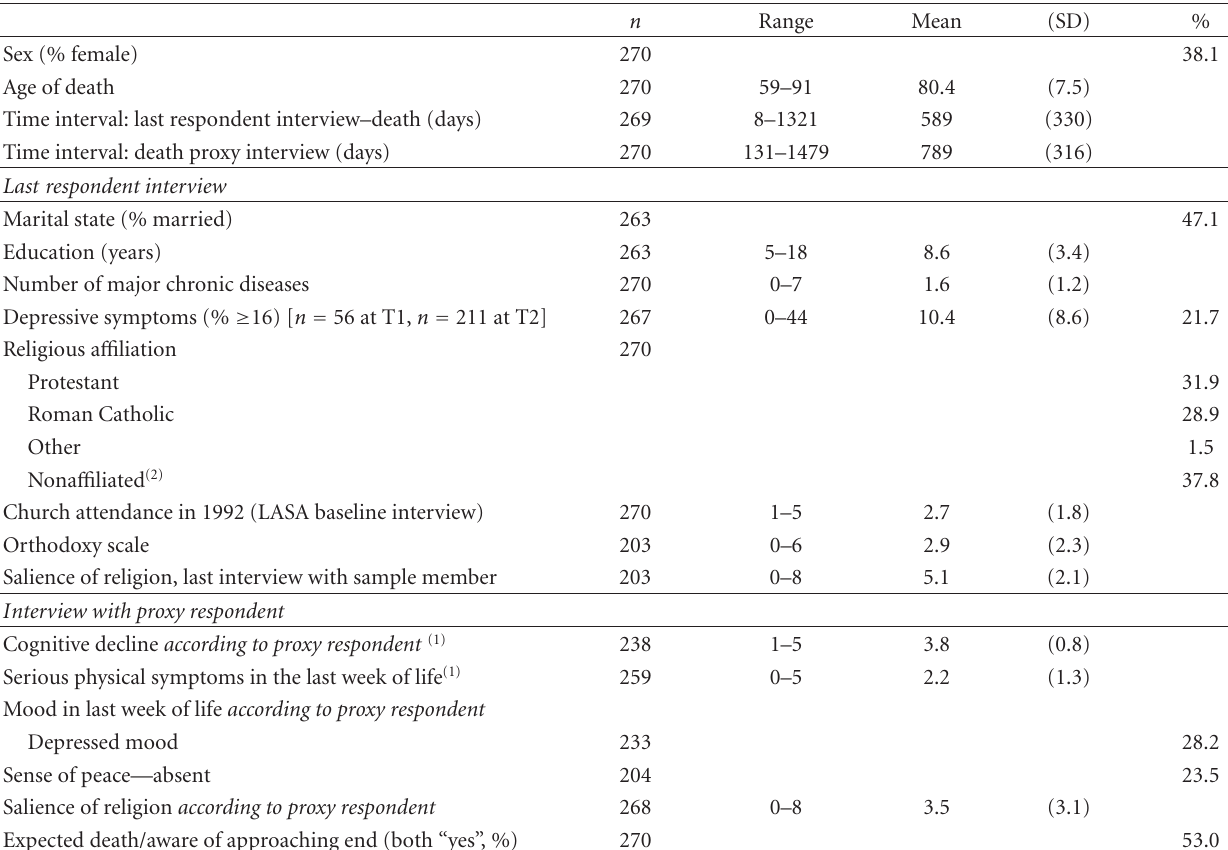
Table 1: Characteristics of deceased sample members of the Longitudinal Aging Study Amsterdam (LASA) between 1995 and